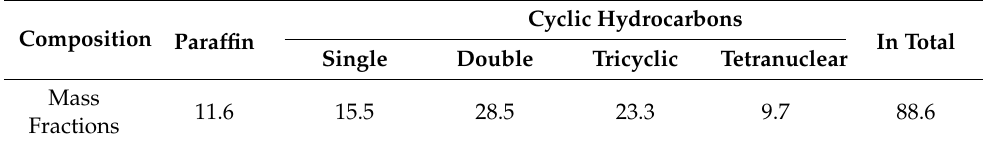
Table 1. Main components and their mass fractions of Karamay 25 # insulating oil.